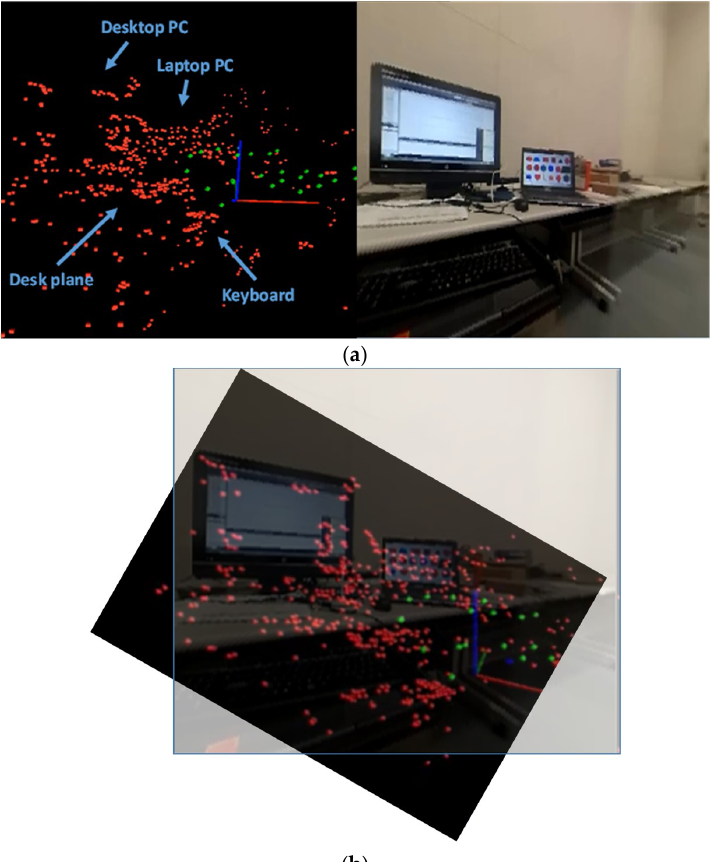
Figure 6. The map produced in the desk video. ( a ) map points and its corresponding real situation; ( b ) the map points are coincide with the real situation.